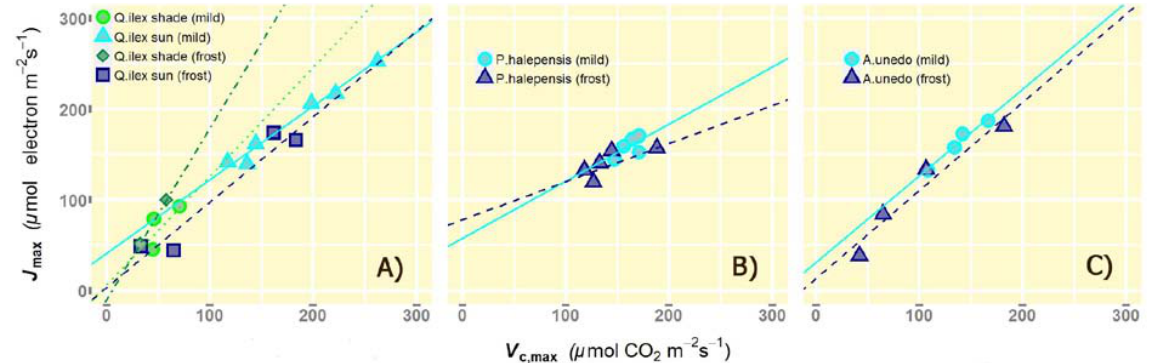
3 Figure 9. Relationship between the maximum velocity of carboxylation ( V c , max ) and the maximum rate of electron transport ( J max ) in (a) Q. ilex , (b) P. halepensis and (c) A. unedo leaves. Leaves measured under mild conditions are indicated by green circles and cyan triangles in shaded and sunlit locations, respectively. Leaves measured after the period of frost are indicated by green diamonds and blue squares in shaded and sunlit locations, respectively.